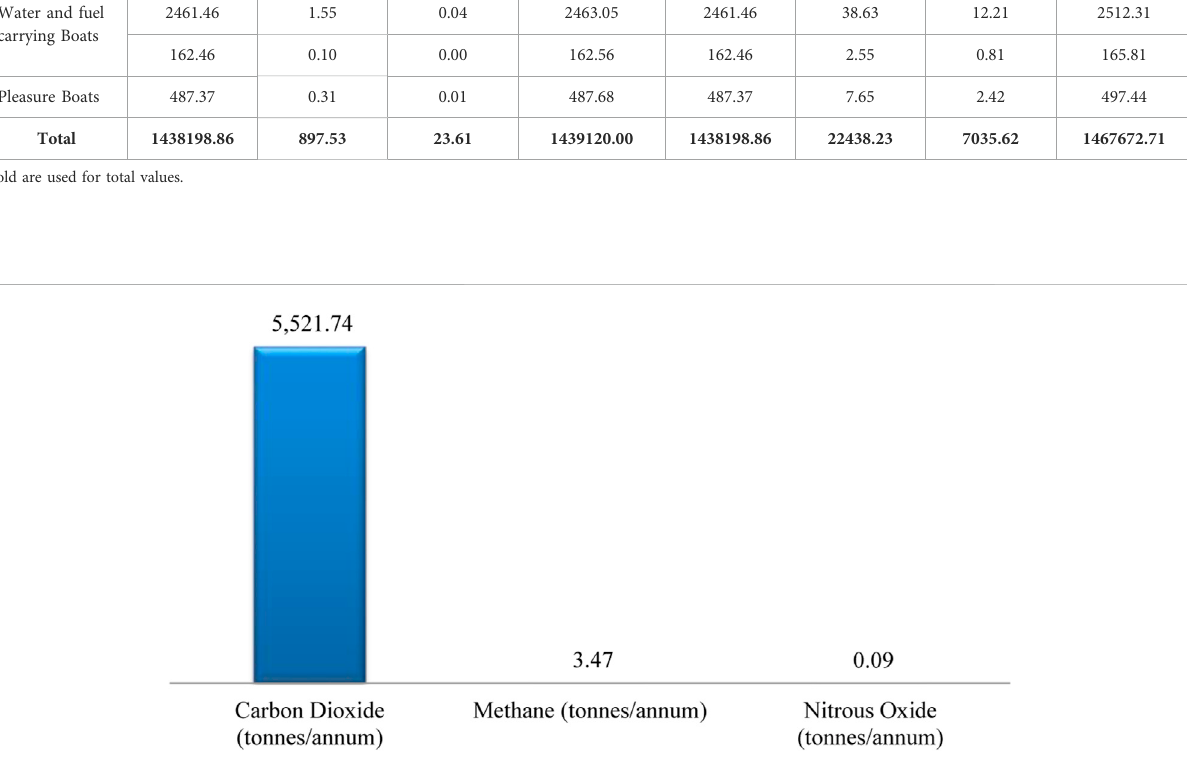
Balochistan based on annual fuel consumption for the period 2021 – 2022. Figure 14 depicts that fi shing vessels are the largest contributor to carbon dioxide emissions among all other types of sea-goingvessels.Fishingvesselsareresponsiblefor305,685.70tonnes of CO 2 emissions. Emissions from skiff boats are 48,822.06 tonnes of CO 2 . Passenger boats and water and fuel-carrying boats are responsible for 24,102.61 tonnes and 4,824.46 tonnes of CO 2 . On contrary, methane and nitrous oxide emissions from all types of sea- going vessels are very low.